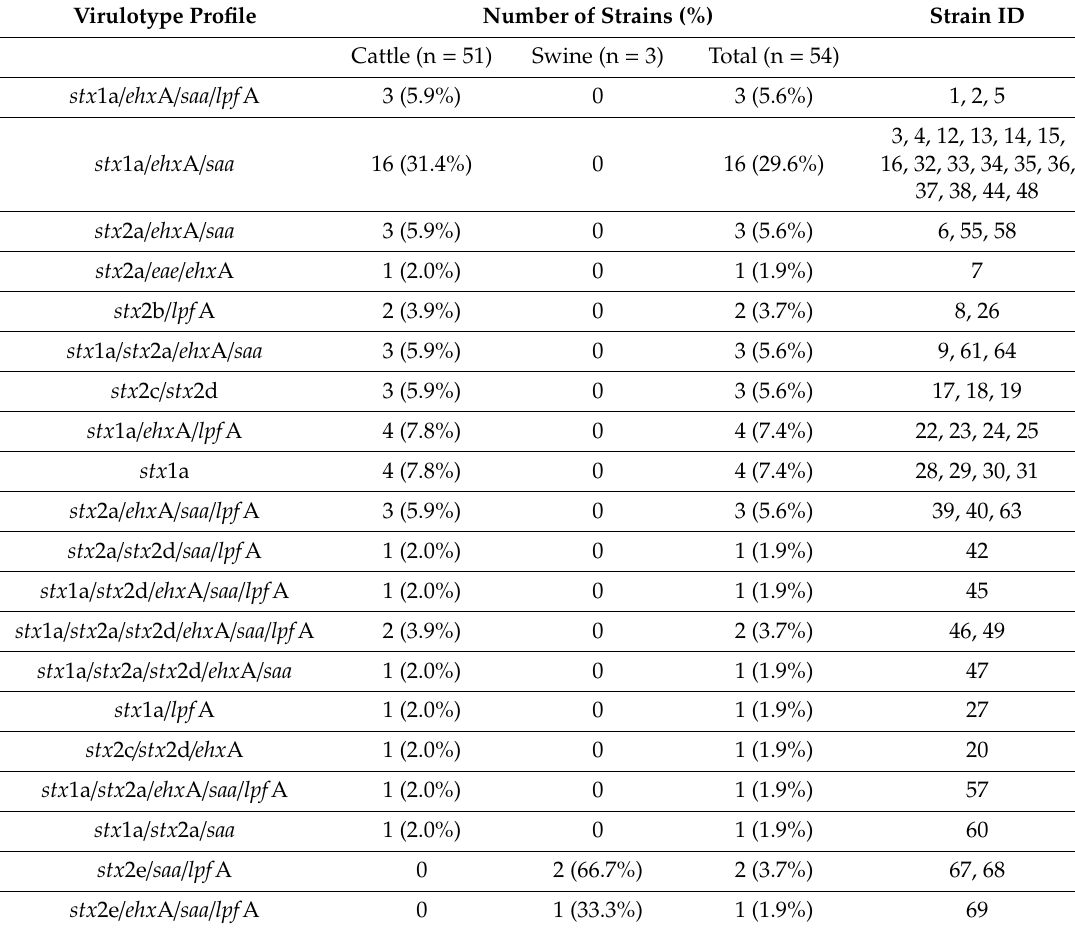
Table 2. Virulotypes detected in STEC strains isolated from cattle and swine. Virulotype